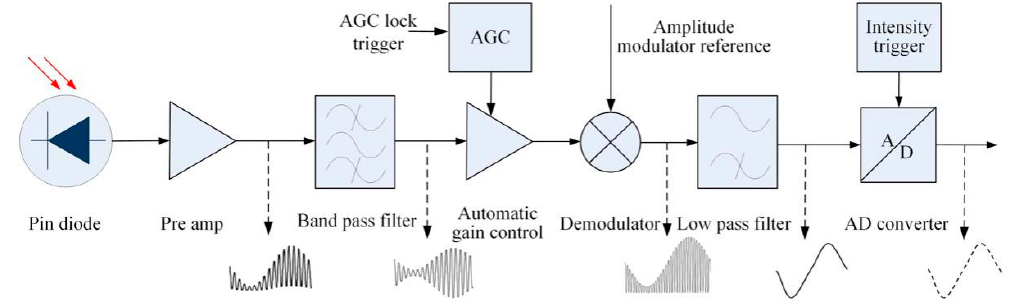
Figure 3. Schematic functional block and electrical layout of signal processing.